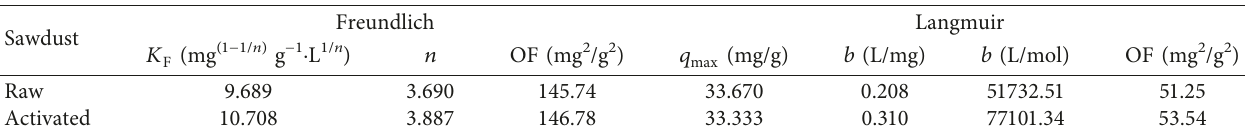
Table 2: Comparison of the optimized Freundlich and Langmuir isotherms parameters for the adsorption of chrysoidine on raw and chemically treated